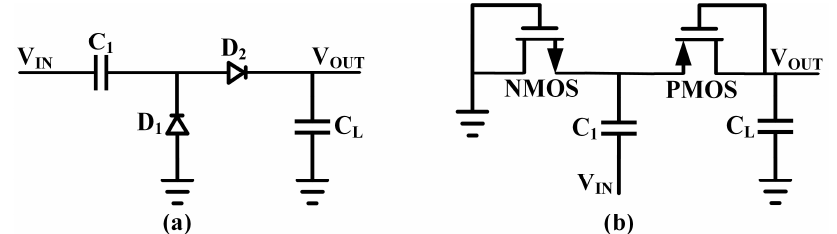
Figure 2. Conventional rectifier. ( a ) Diode-based voltage doubler and ( b ) diode-connected Metal- Oxide-Semiconductor (MOS) based voltage